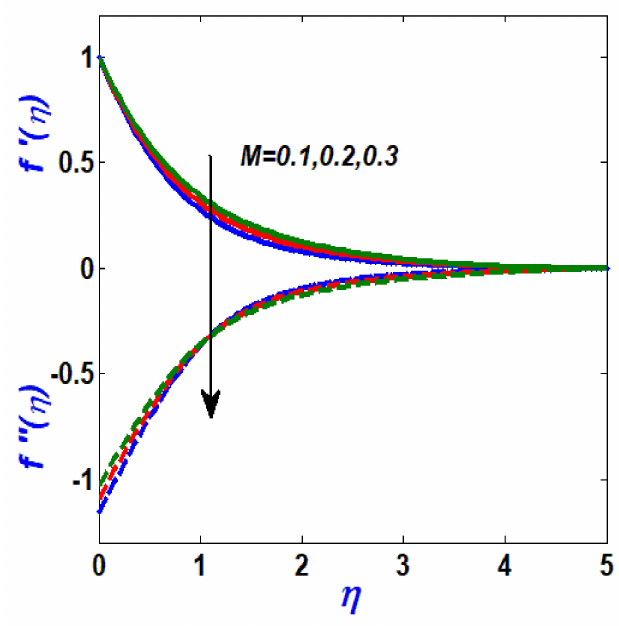
Figure 2. Velocity & acceleration profiles with variation in M .